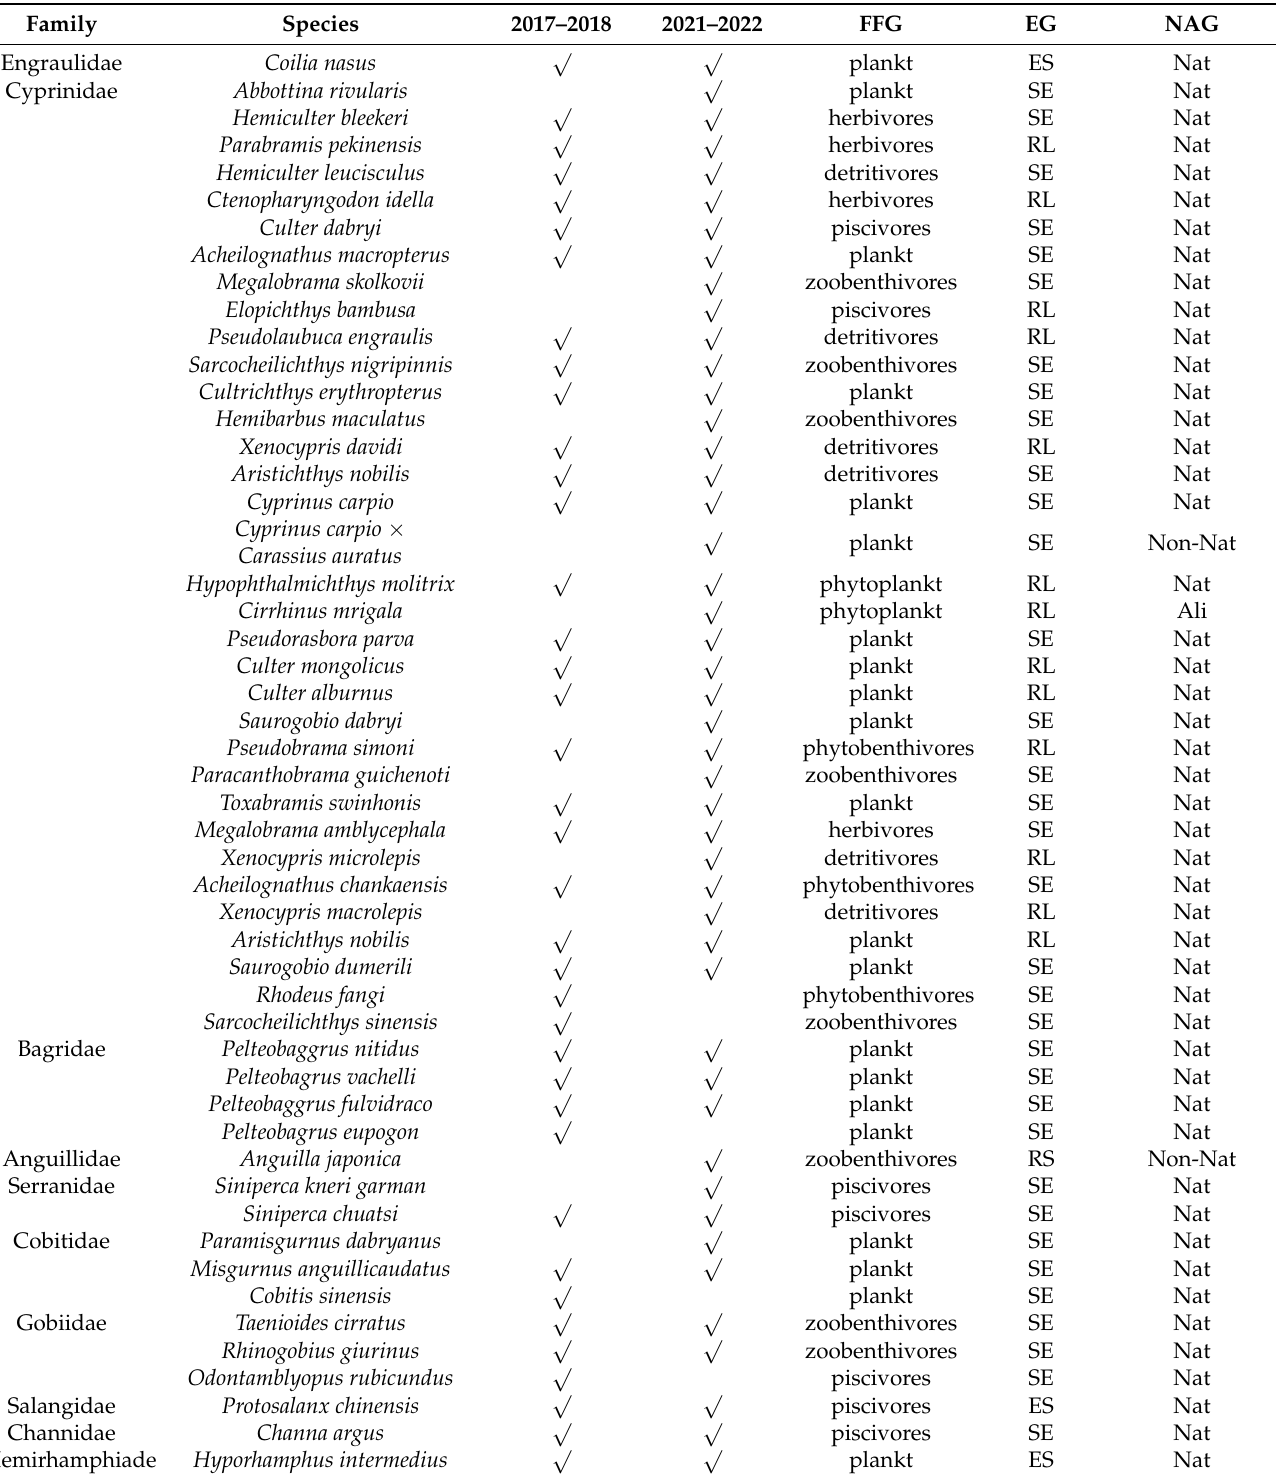
Table 1. Fish species composition between the two periods in Gehu